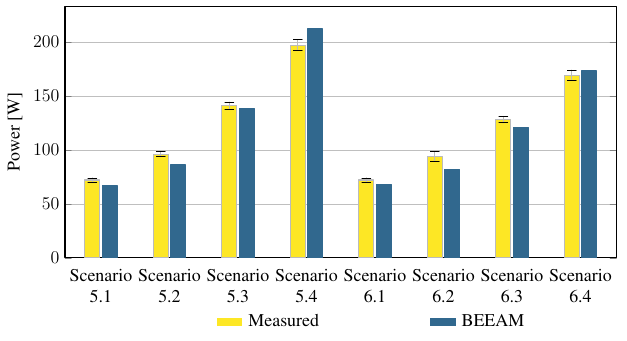
Figure 22. Predicted versus measured total system power losses, Scenarios 5 and 6. Discrepancies between simulated and measured power values were likely